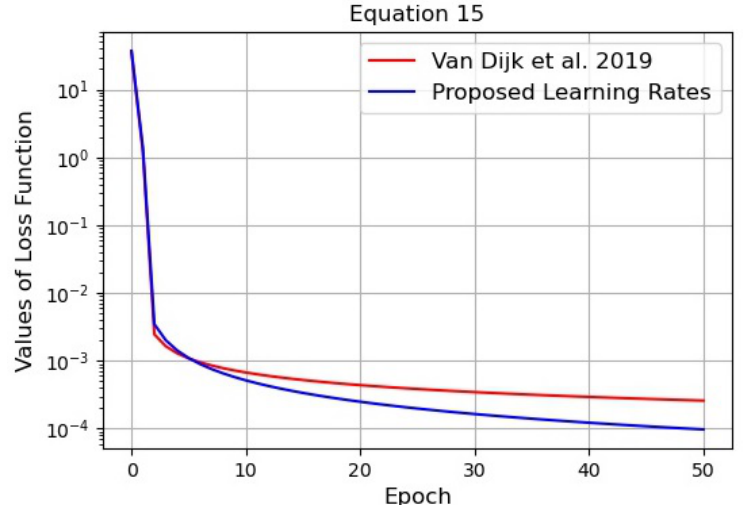
Figure 1. Values of loss function and convergence rate for convex binary problem [1].